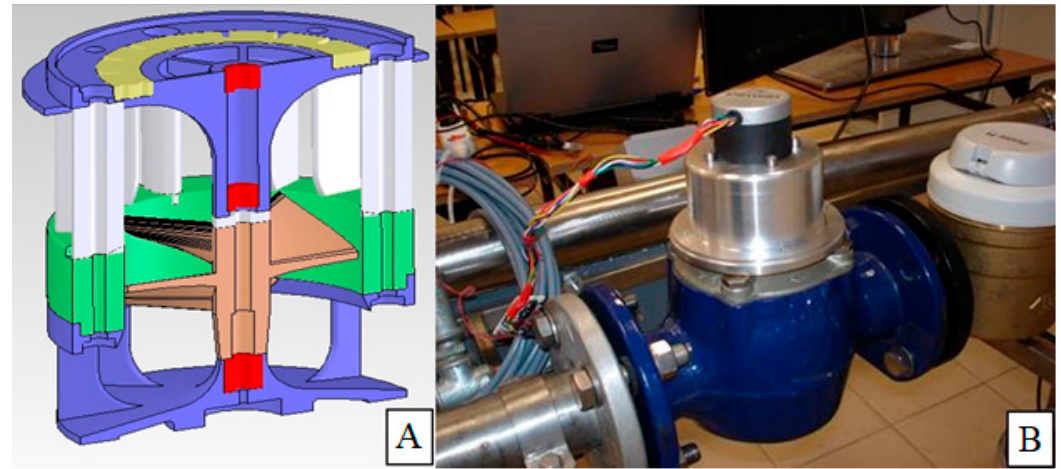
Figure 2. Cross-section of ( A ) a mini generator model with sliding sleeves marked (in red), ( B ) the real